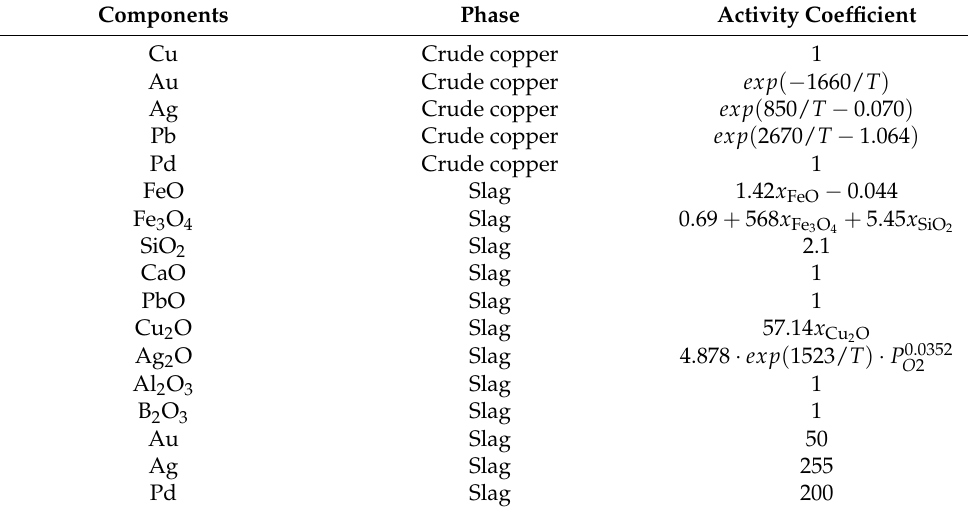
Table 1. The activity coefficient of different components